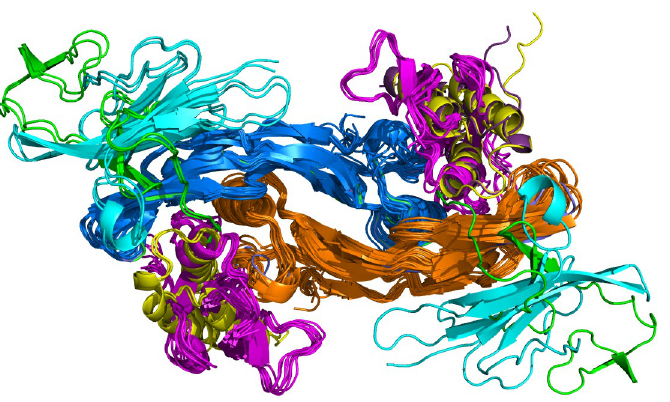
Fig 7. Biological assemblies of human bone morphogenetic protein 2 (BMP2_HUMAN downloaded with PDBrenum. BMP2 is a homodimer (orange and blue) that binds Type I (magenta) and Type II receptors (cyan), RGM domain family members (yellow), and von Willebrand factor C-terminal domains (green).